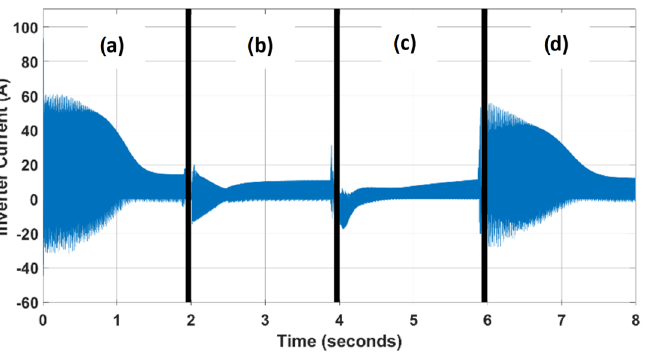
Figure 5. Inverter current, constant load at variable speed. With speed steps from: (a) 0% to 100%; (b) 100% to 80%; (c) 80% to 35%; (d) 35% to 90%.